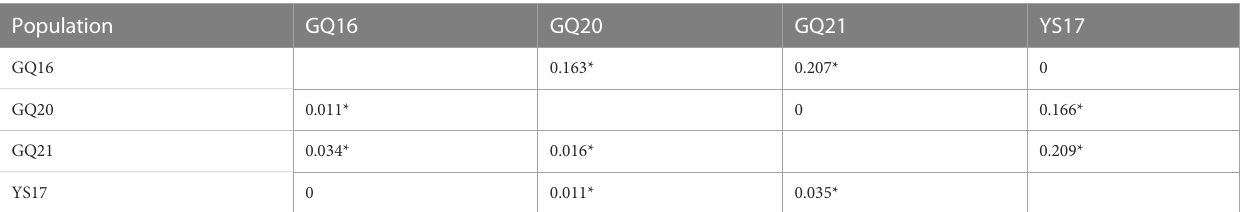
*indicates signi fi cance at P < 0.05 level for F st values.